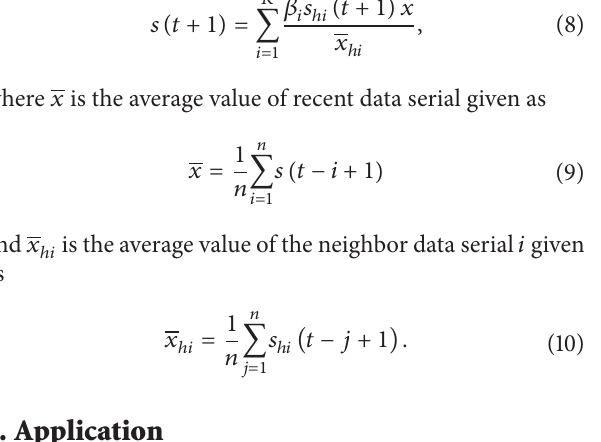
coefficient with average value of recent data serial is